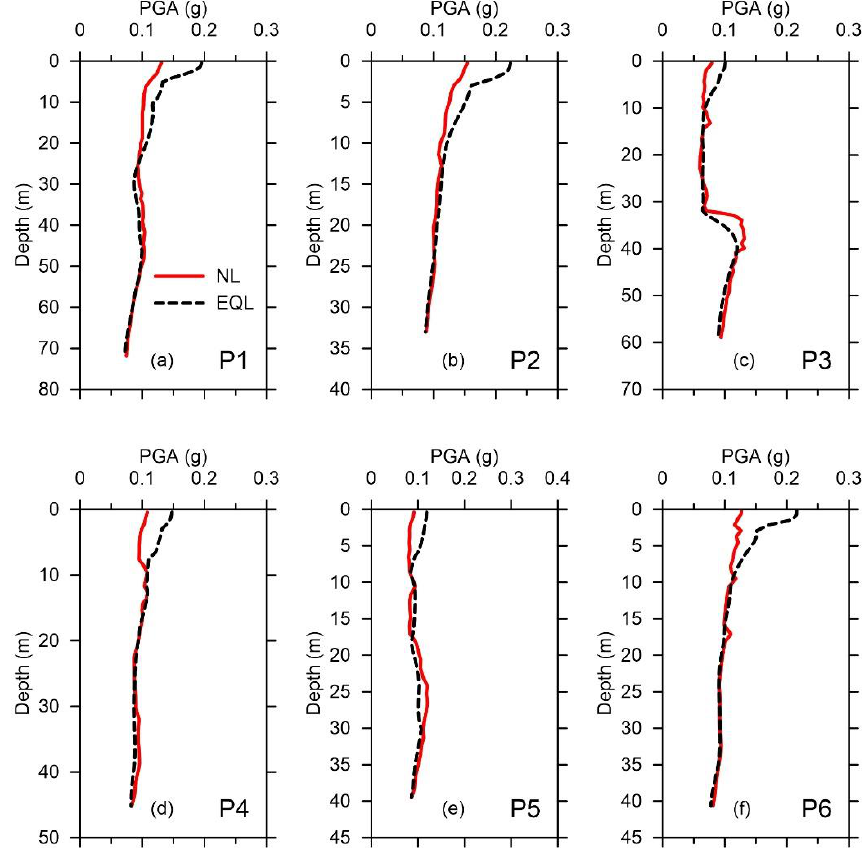
Figure 11. Maximum PGA of soil profiles: ( a – f ) P1 – P6.